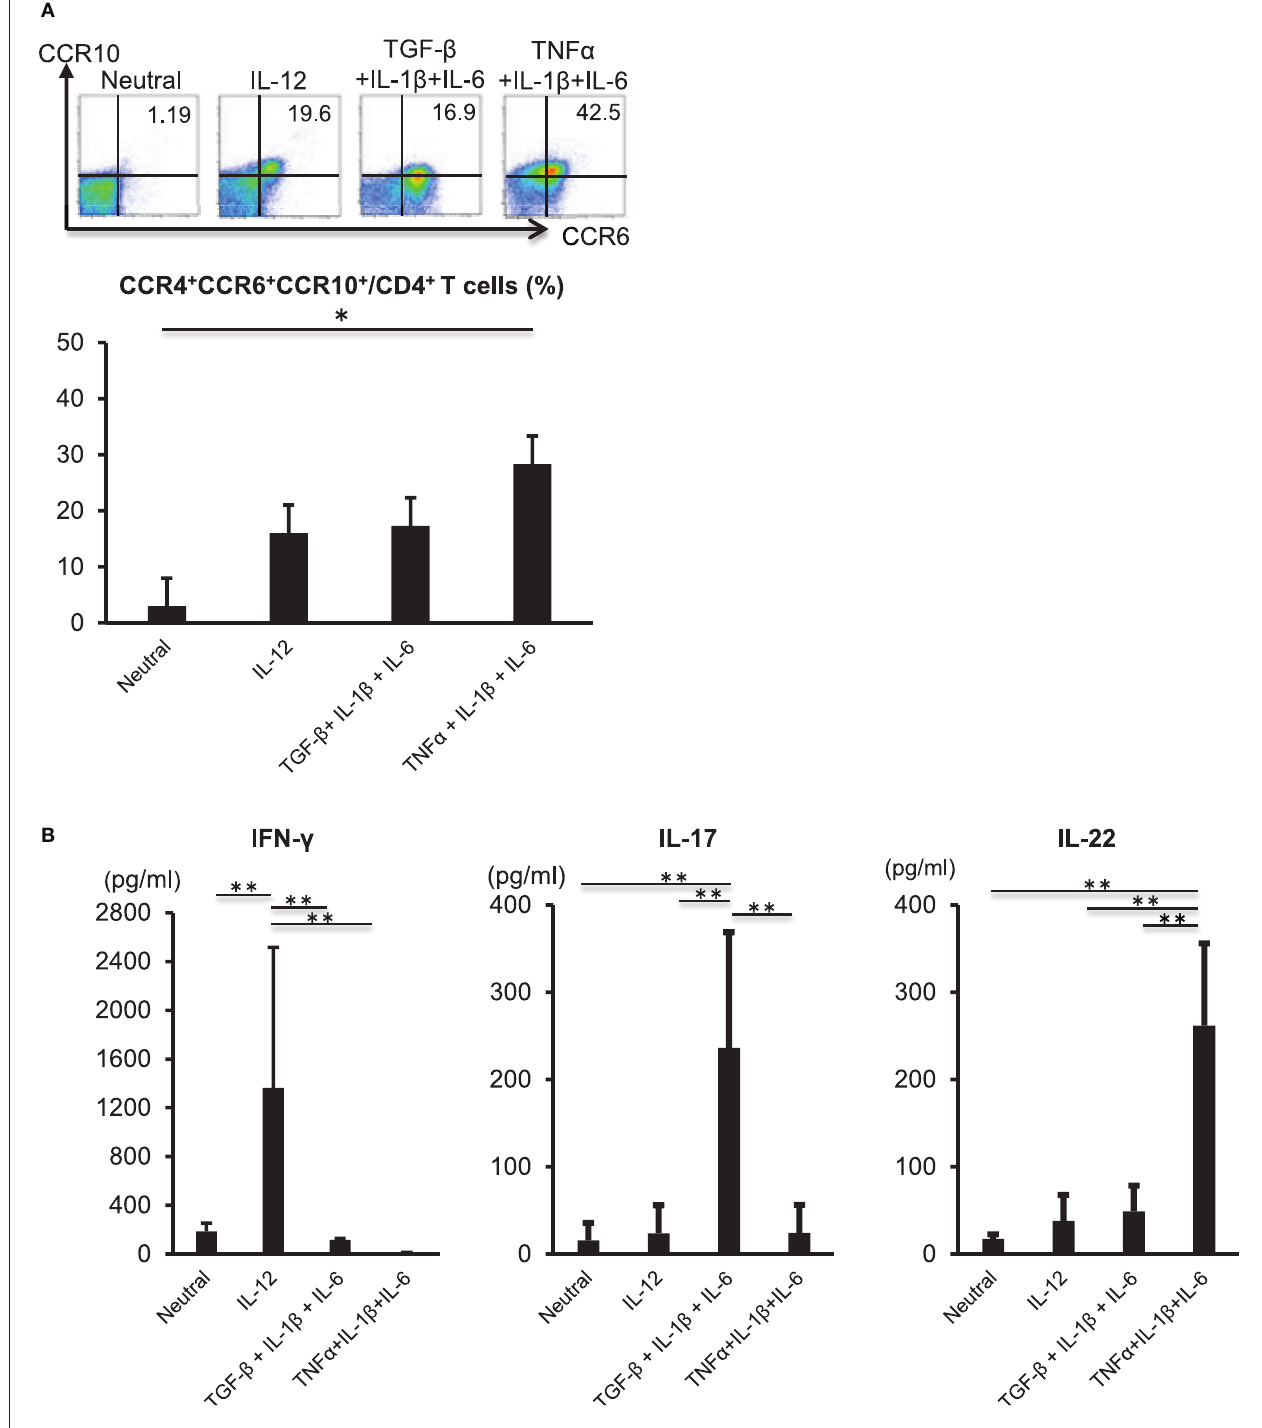
FIGURE 2 | Differentiation of Th22 cells is induced by IL-6, TNF α , and IL-1 β . (A) Expression of CCR4, CCR6, and CCR10 by helper T cells stimulated with plate-bound anti-CD3 and -CD28 antibodies in the absence (Neutral) or presence of various combinations of IL-12, TGF- β , IL-1 β , IL-6, and TNF α (above plots). Numbers in plots indicate the percentage of cells in each quadrant. Data are representative of five independent experiments. Frequency of CCR4 + CCR6 + CCR10 + CD4 + T cells ( bottom ). Data represent the mean ± standard deviation of five independent experiments. (B) Production of IFN- γ , IL-17, or IL-22 among helper T cells stimulated with TCR and various combinations of cytokines as described in (A) . Cytokine levels were assessed in culture supernatants. * p < 0.05 and ** p < 0.01 according to the Bonferroni method.